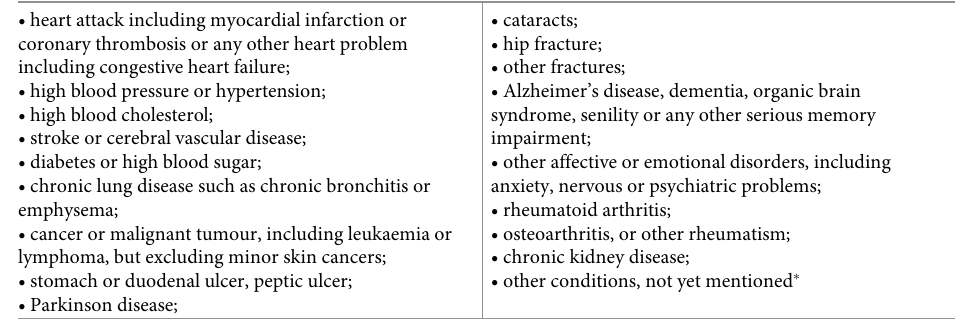
Table 1. List of